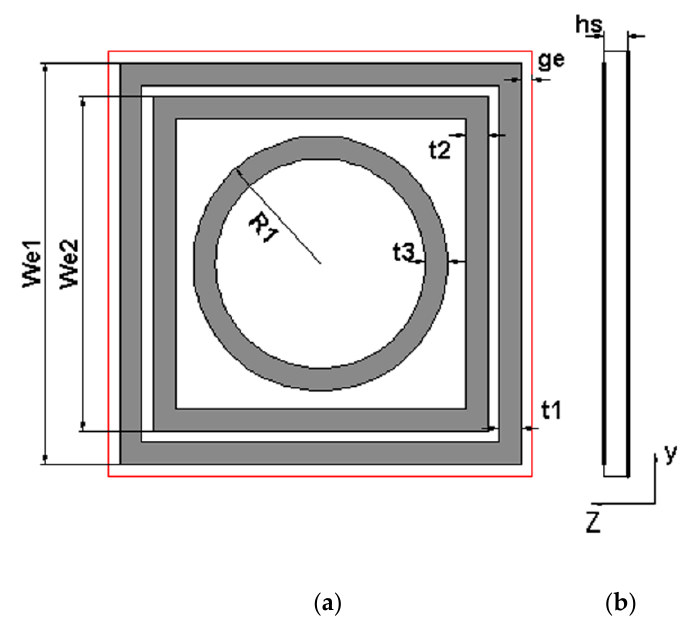
Figure 7. The geometry of the proposed EBG unit. ( a ) Front view. ( b ) Side view.